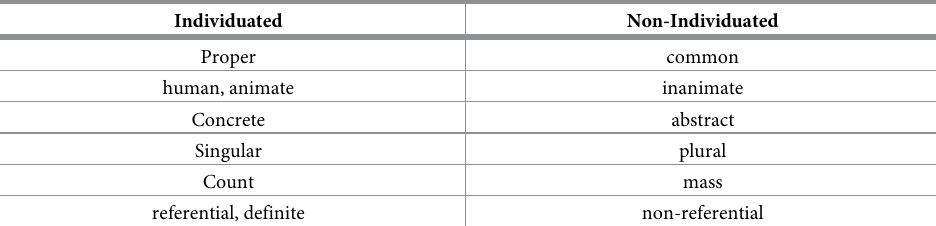
Table 2. The subparameters comprising I NDIVIDUATION